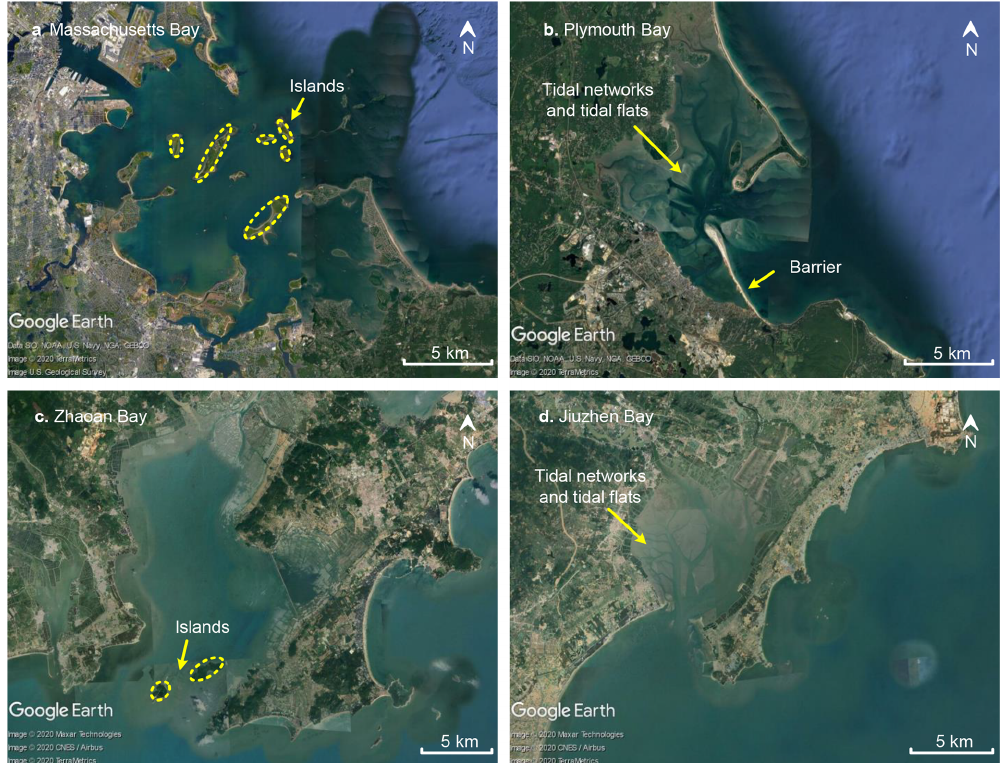
Figure 1. Aerial view of two sets of tidal barrier basins (about 30–40km from each other) along the eastern coast of the US and the southern coast of China. (a) Massachusetts Bay (42 ◦ 18 (cid:48) 36 (cid:48)(cid:48) N, 70 ◦ 58 (cid:48) 12 (cid:48)(cid:48) W); (b) Plymouth Bay (42 ◦ 00 (cid:48) 18 (cid:48)(cid:48) N, 70 ◦ 39 (cid:48) 18 (cid:48)(cid:48) W); (c) Zhao’an Bay (23 ◦ 40 (cid:48) 12 (cid:48)(cid:48) N, 117 ◦ 18 (cid:48) 36 (cid:48)(cid:48) E); (d) Jiuzhen Bay (23 ◦ 59 (cid:48) 6 (cid:48)(cid:48) N, 117 ◦ 42 (cid:48) 36 (cid:48)(cid:48) E). Image © Google Earth 2020, TerraMetrics.